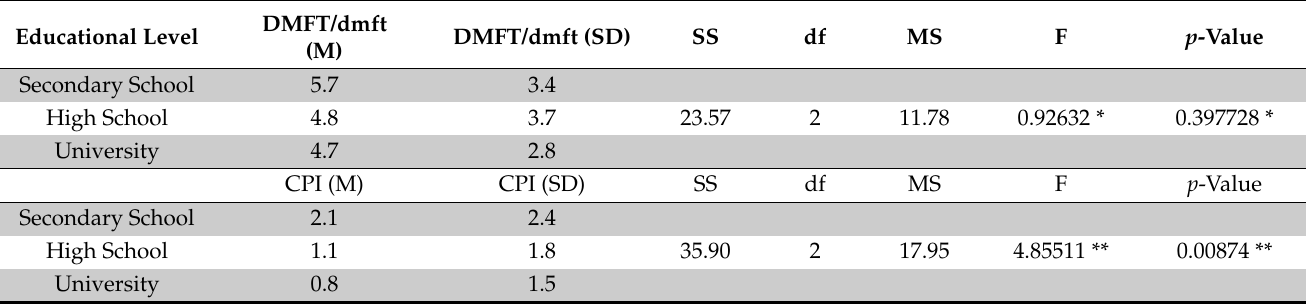
Table 4. DMFT/dmft Index and CPI adjusted for Educational Level: ANOVA